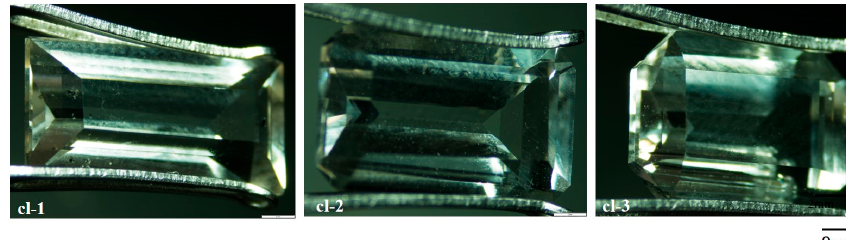
Figure 1. Pictures of colorless scapolites.